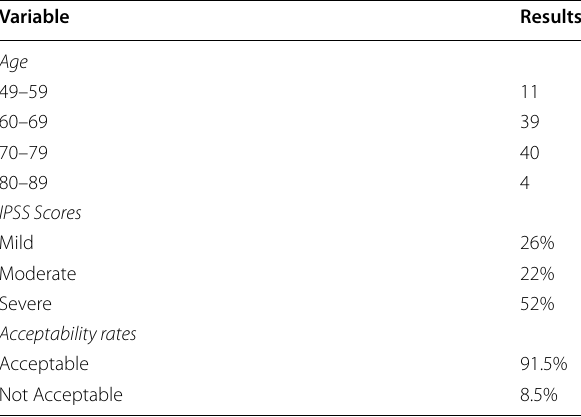
Table 1 Baseline characteristics of study